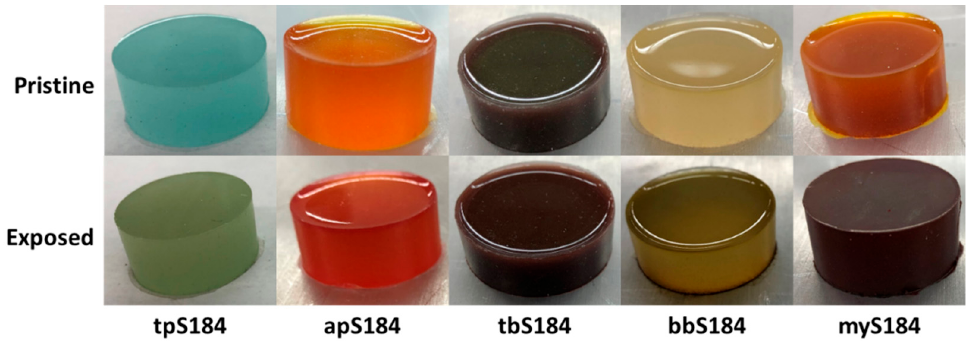
Figure 2. Comparison of the color changes between pristine and exposed composite chromophoric sensors (0.5 wt.%).